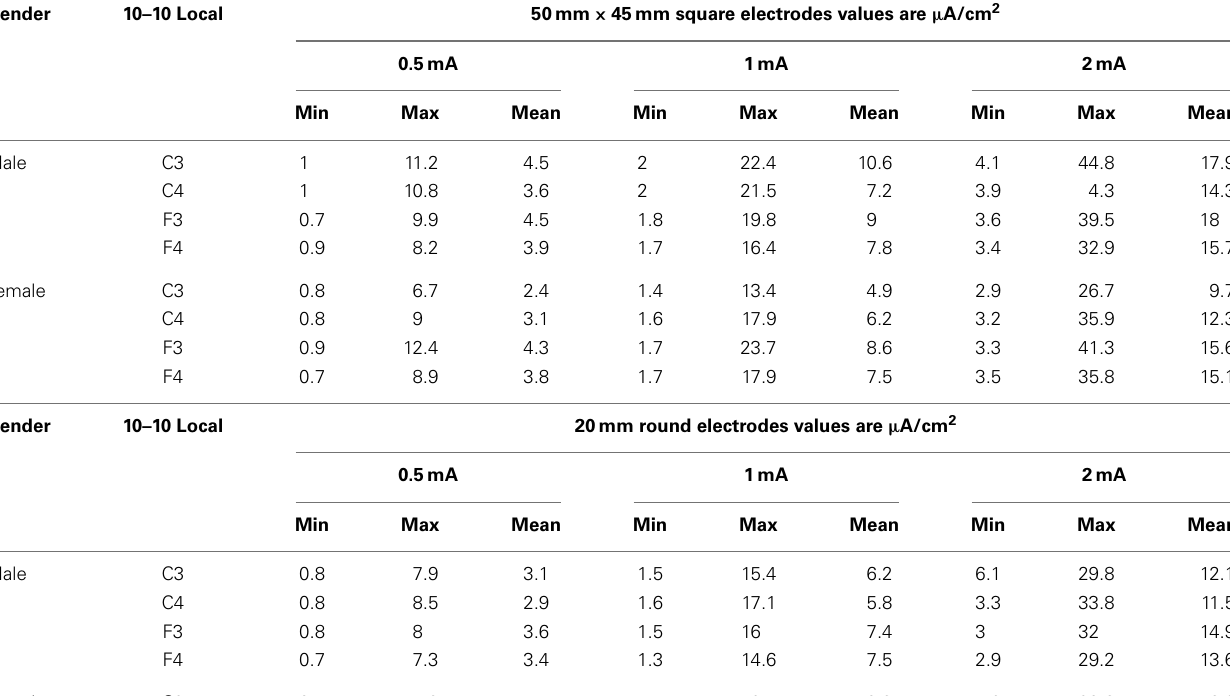
Table 1 |The table below shows the minimum, maximum and mean values by gender and stimulus intensity for each size of electrode 50mm by 45 square and 20mm round